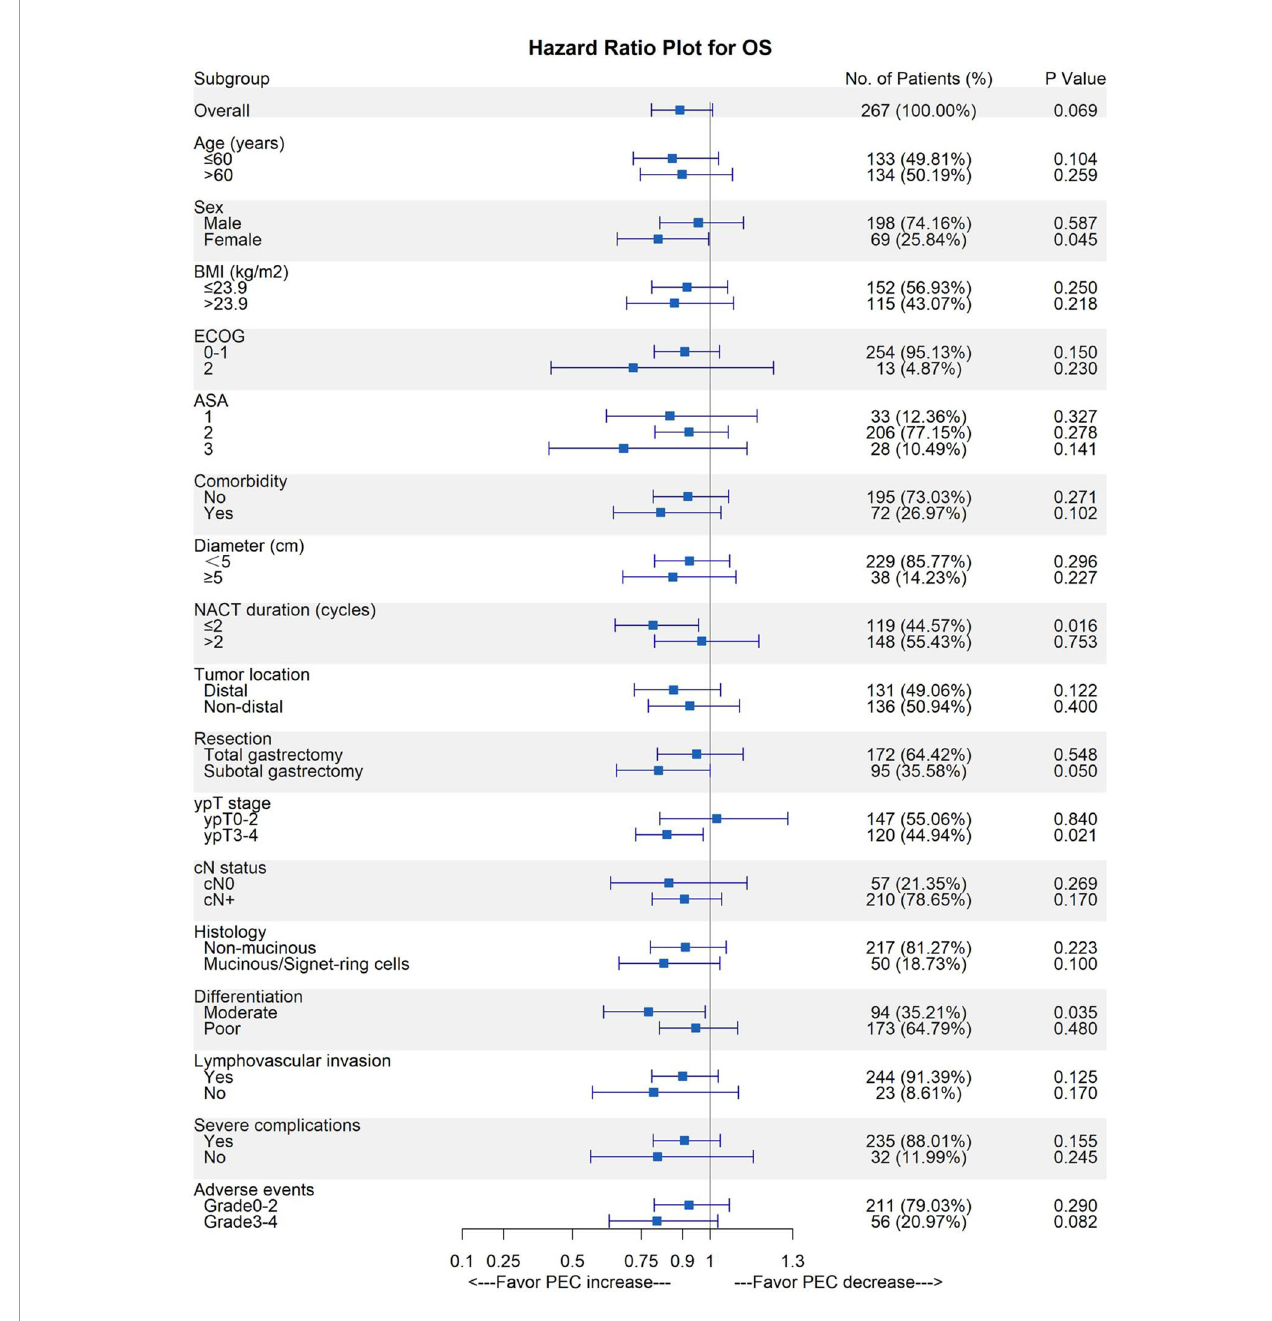
FIGURE 4 | Forest plot for OS bene fi t from PEC increase in each